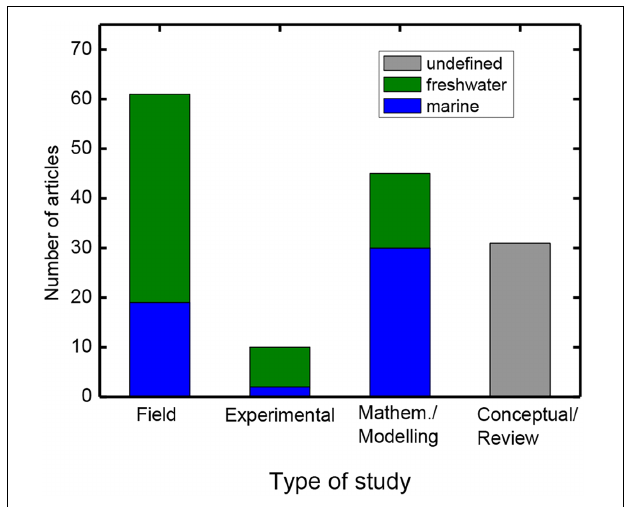
FIGURE 1 | Results of the literature search using “phytoplankton” AND “trait ∗ .” From a total 631 articles, 150 were selected that used a trait-based approach to study phytoplankton ecology. The remaining studies were assigned to four different types according to their predominant approach and according to ecosystem type. The conceptual/review articles were often not specific to a habitat type, so no further distinctions were